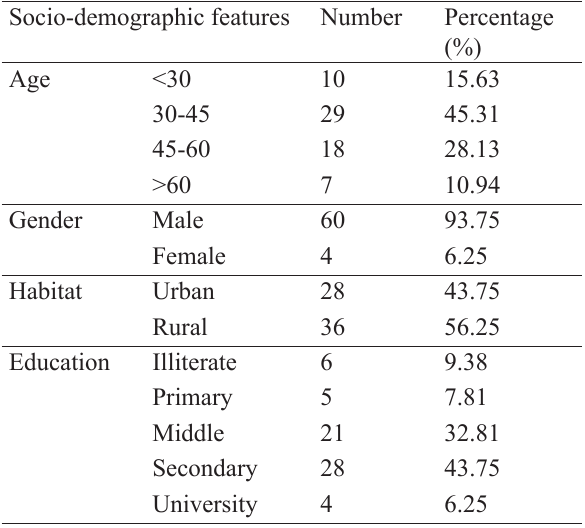
Table 1. Socio-demographic features of the informants. Socio-demographic